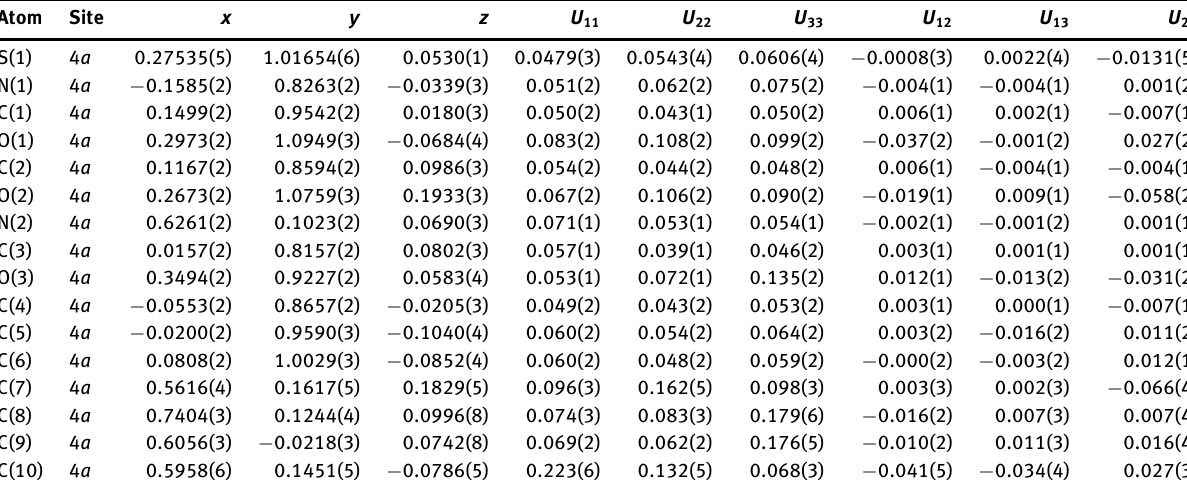
Table 3: Atomic displacement parameters (Å 2